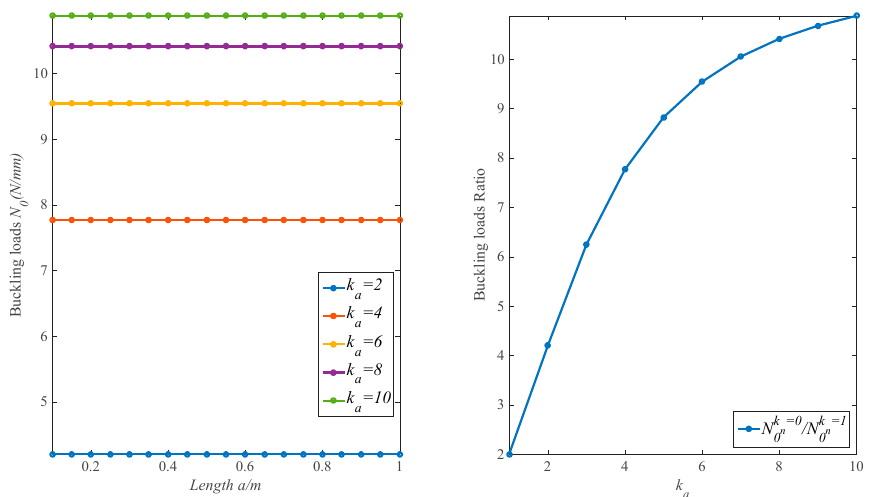
Figure 6. Change rate of buckling loads affected by geometrical parameter k a and the dimensions.